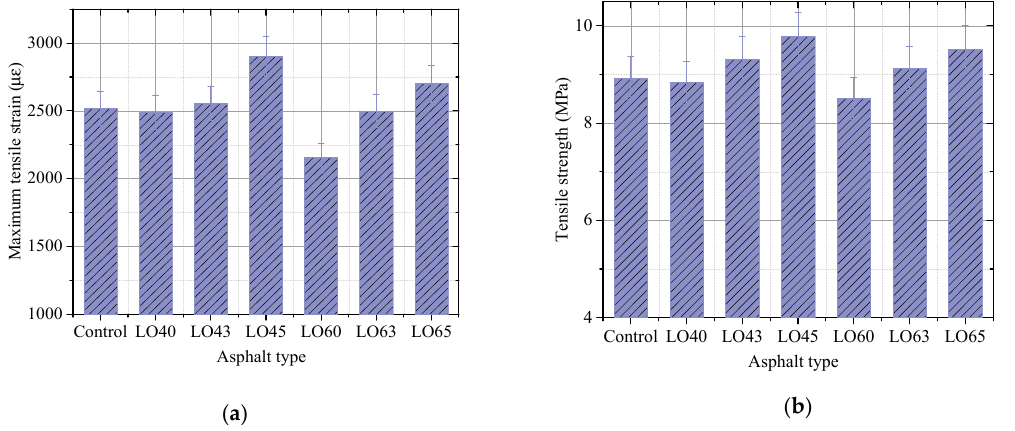
Figure 9. The maximum tensile strain and tensile strength. ( a ) Maximum tensile strain; ( b ) Tensile strength.